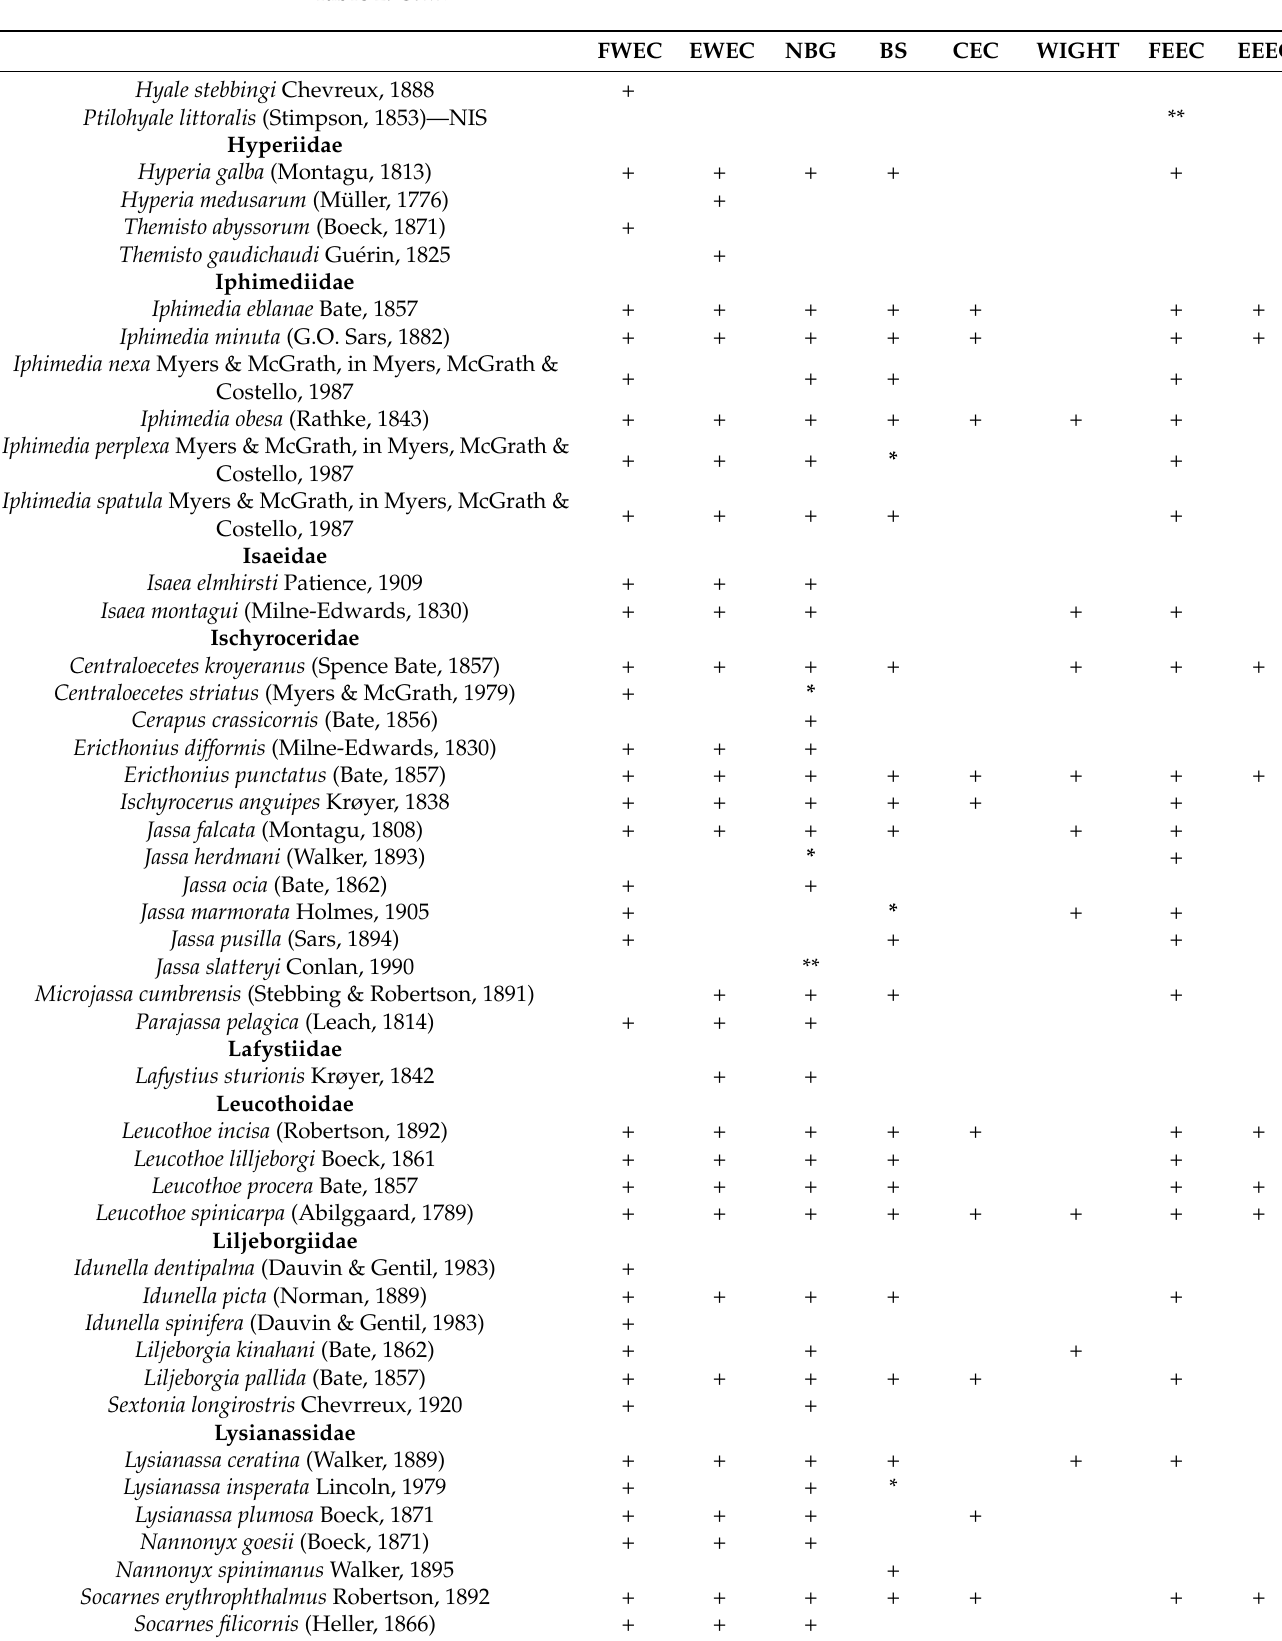
Table 2. Cont. FWEC EWEC NBG BS CEC WIGHT